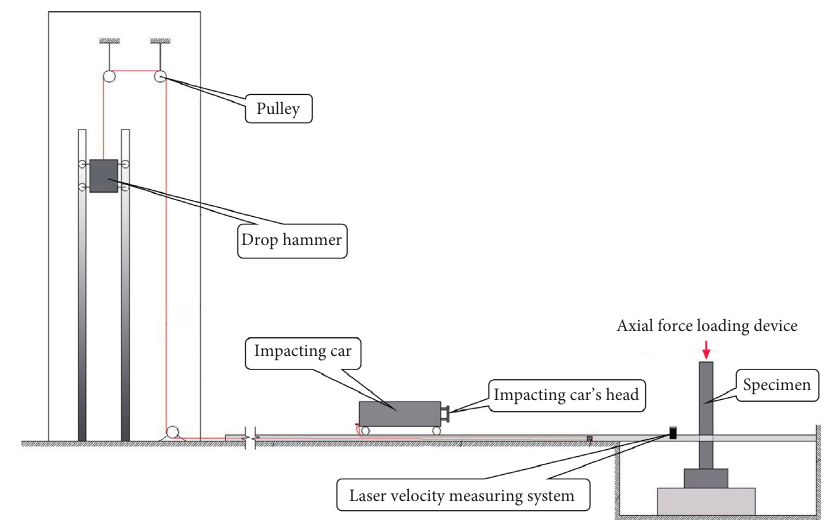
Figure 2: Ultrahigh drop hammer impact test system diagram.